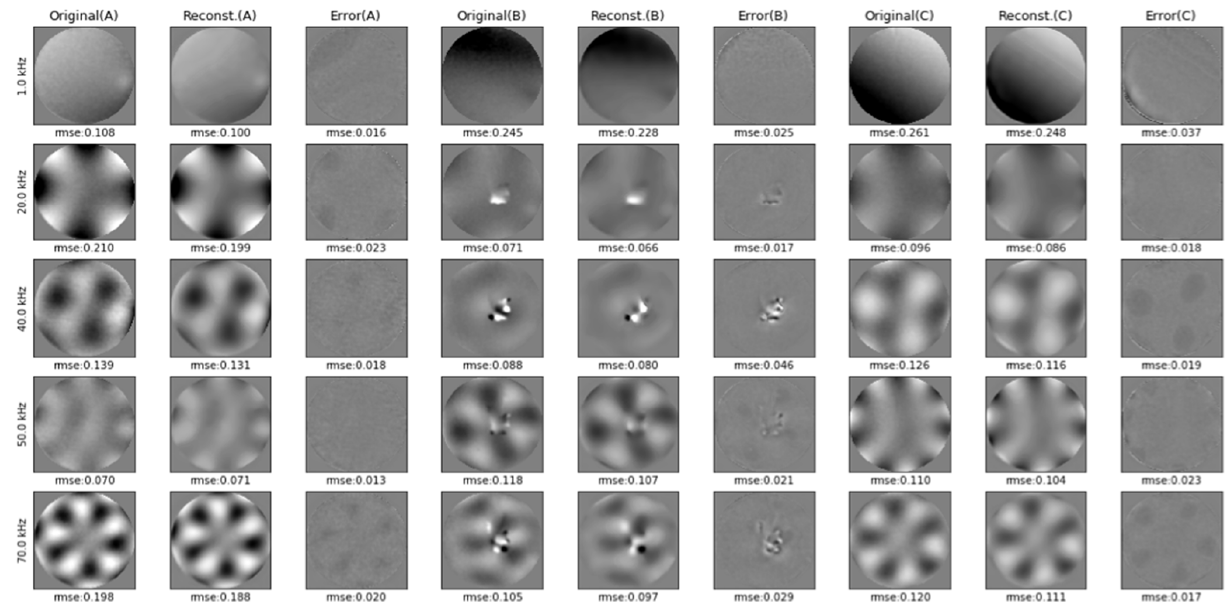
Figure 7. Inputs, outputs, and reconstruction errors for specimen (a), (b), and (c). ( A – C ) corresponds to specimen (a), (b), and (c), respectively.